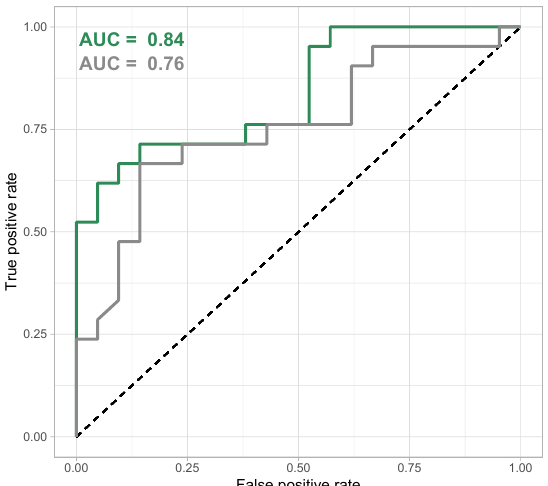
Figure 6. Receiver Operation Characteristics (ROC) curve for random forest classification model based on all features (green) and on identified features only (grey). The area under the Receiver Operation Characteristics curve is used as a quality metric for classification models and shows a good classification for a random forest classification model that uses all features in the data set, compared to a slightly weaker performance for a model that only considers identified